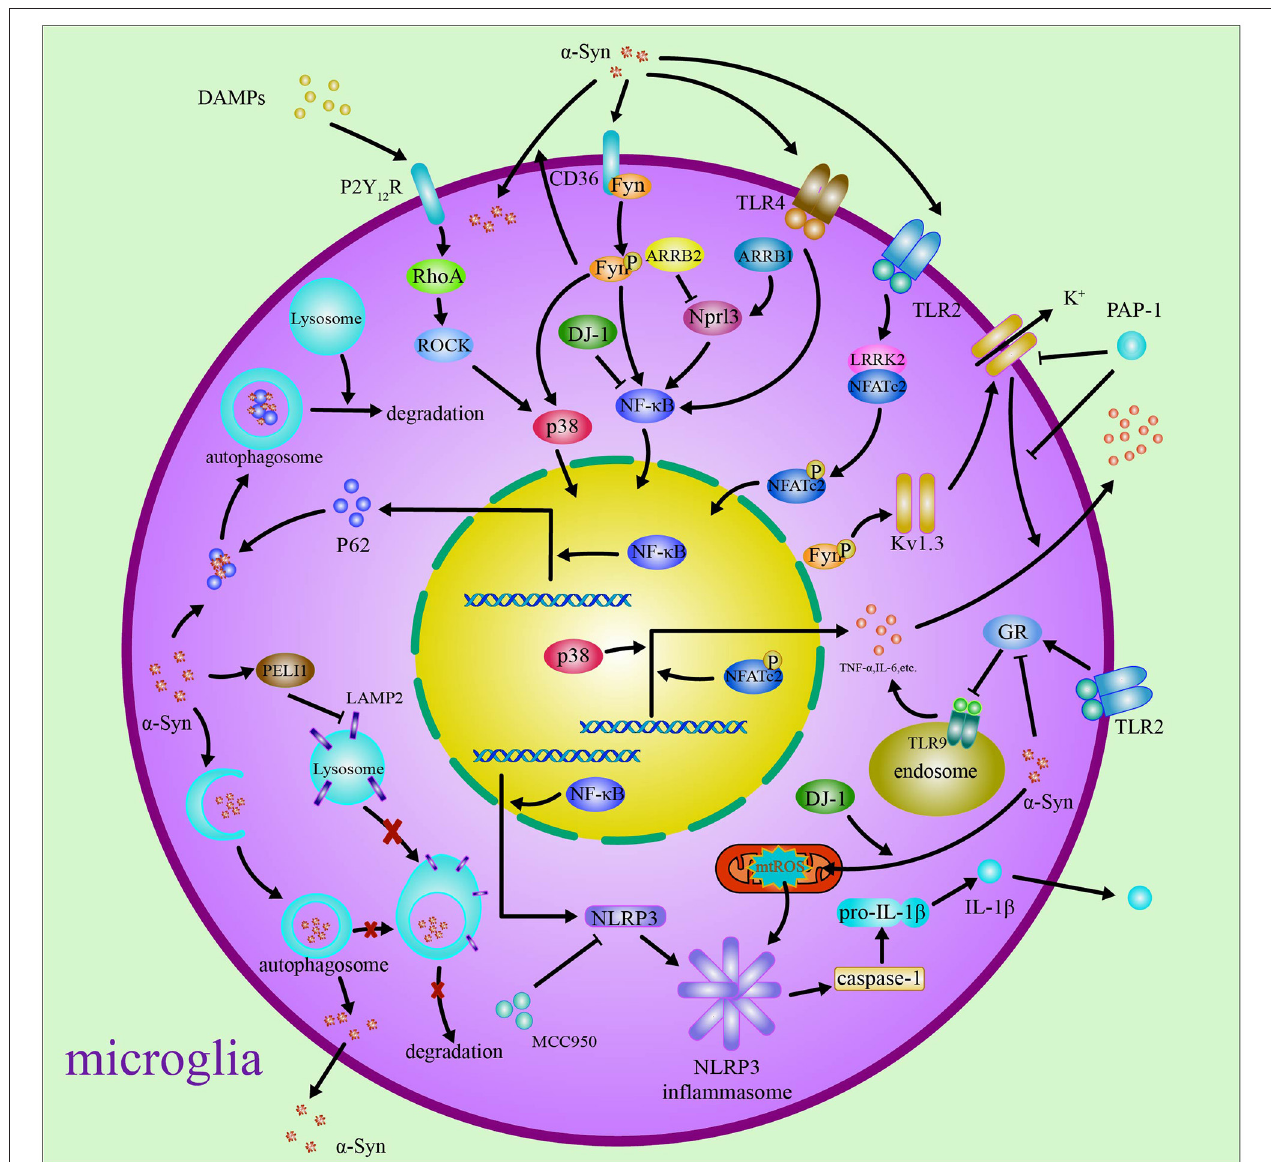
FIGURE 1 | Microglia in Parkinson’s disease. In Parkinson’s disease, debris containing α -syn and DAMPs from neurons activates microglia through regulating Fyn, Kv1.3, and P2Y 12 R via ROCK and p38 MAPK pathways. The α -syn induces neuroinflammatory response through activating TLR4/TLR9/TLR2, NLRP3 inflammasome, ARRB1/ARRB2/STAT1/NF- κ B/NLPR3, and LRRK2/NFAT pathways. The phagocytized α -syn impairs the autophagy through PELI1, TLR4/p62/SQSTM1, and p38/TFEB/NLRP3